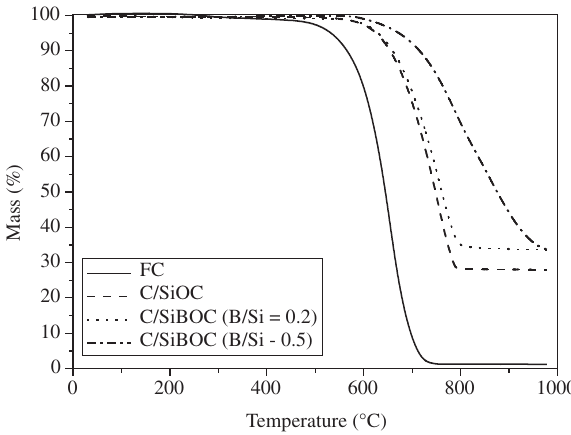
Figure 4. TGA curves of the carbon fiber and the CMCs obtained at 1000 °C for the PS and PBS derived-MTES (air, 10